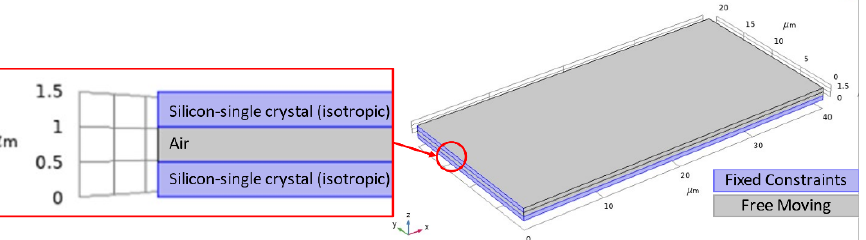
Figure 5. COMSOL simulated microcantilever geometry with a length and width of 40 µm and 20 Figure 5. COMSOL Multiphysics ® software simulated microcantilever geometry with a length and µm, respectively. The top and bottom layers are composed of silicon-single crystal (isotropic) and width of 40 µ m and 20 µ m, respectively. The top and bottom layers are composed of silicon-single the middle layer, which forms the cavity is an air domain. The top electrode, air cavity, and bottom crystal (isotropic) and the middle layer, which forms the cavity is an air domain. The top electrode, electrode each have a thickness of 0.5 µm. Boundaries shown in blue are fixed while the grey air cavity, and bottom electrode each have a thickness of 0.5 µ m. Boundaries shown in blue are fixed boundaries are free to move. while the grey boundaries are free to move. Material properties for COMSOL Multiphysics ® software simulations for microcantilever, microbridge, and clamped membrane geometries. thickness of 40 µm, 20 µm, and 0.5 µm, respectively. In these FEA simulations, the mi- Material